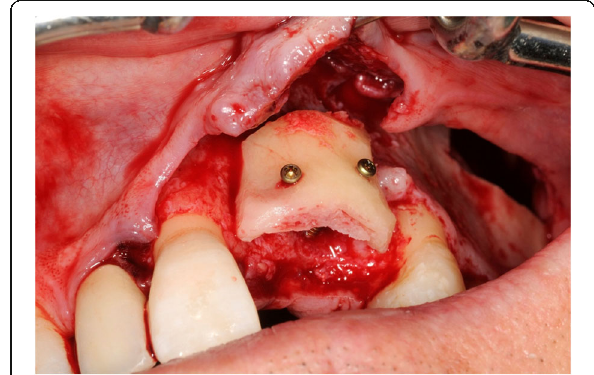
Fig. 2 The harvested bone block at the recipient site of patient